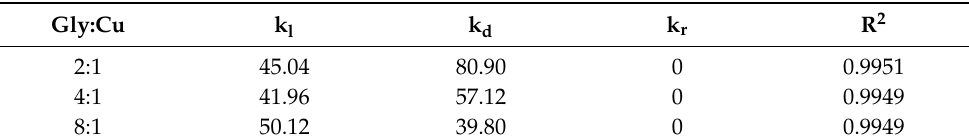
Table 10. Data showing rate-controlling model for chalcopyrite leaching at different Gly:Cu molar ratios using the least square technique of constrained multi-linear analysis.